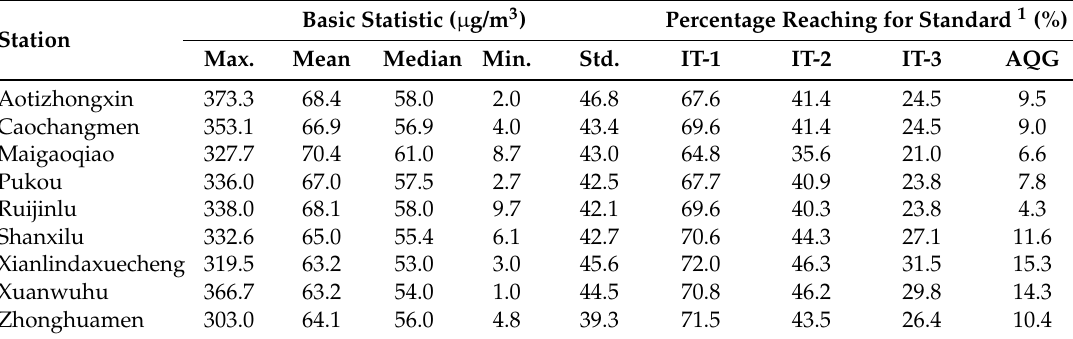
Table 1. The summary of daily average fine particulate matter (PM 2.5 ) concentrations for nine monitoring sites.